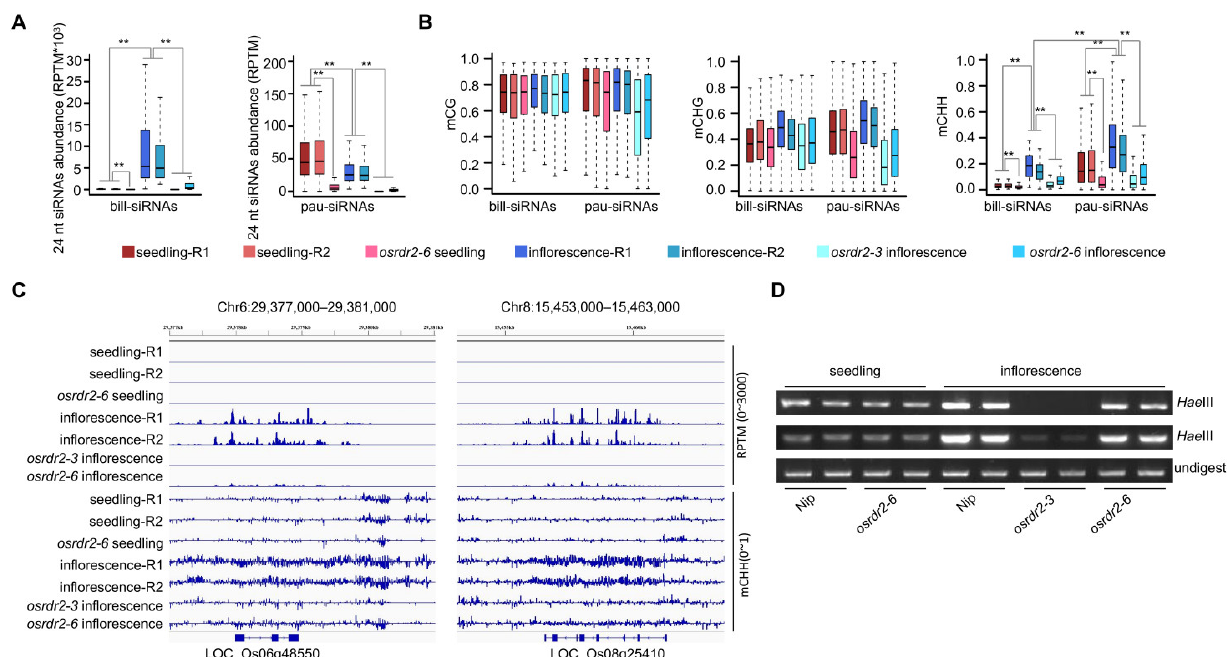
Figure 3. Accumulation of siRNAs and CHH methylation on bill-siRNA clusters depend on OsRDR2. ( A ) Boxplots showing the 24 nt siRNA abundance in seedlings and inflorescences of WT and osrdr2 mutant. ** indicates p < 0.01 by the Wilcoxon sum test. ( B ) Boxplots showing the methylation levels of CG, CHG, and CHH in seedlings and inflorescences of the WT and osrdr2 mutant on bill-siRNA clusters and pau-siRNA clusters in inflorescences. ** indicates p < 0.01 by the Wilcoxon sum test. ( C ) Screen shots of IGV indicating 24 nt siRNA abundance and CHH methylation levels in seedlings and inflorescences of the WT and osrdr2 mutant on two representative bill-siRNA clusters. ( D ) Chop- PCR assay suggesting the CHH methylation level in seedlings and inflorescences of the WT and osrdr2